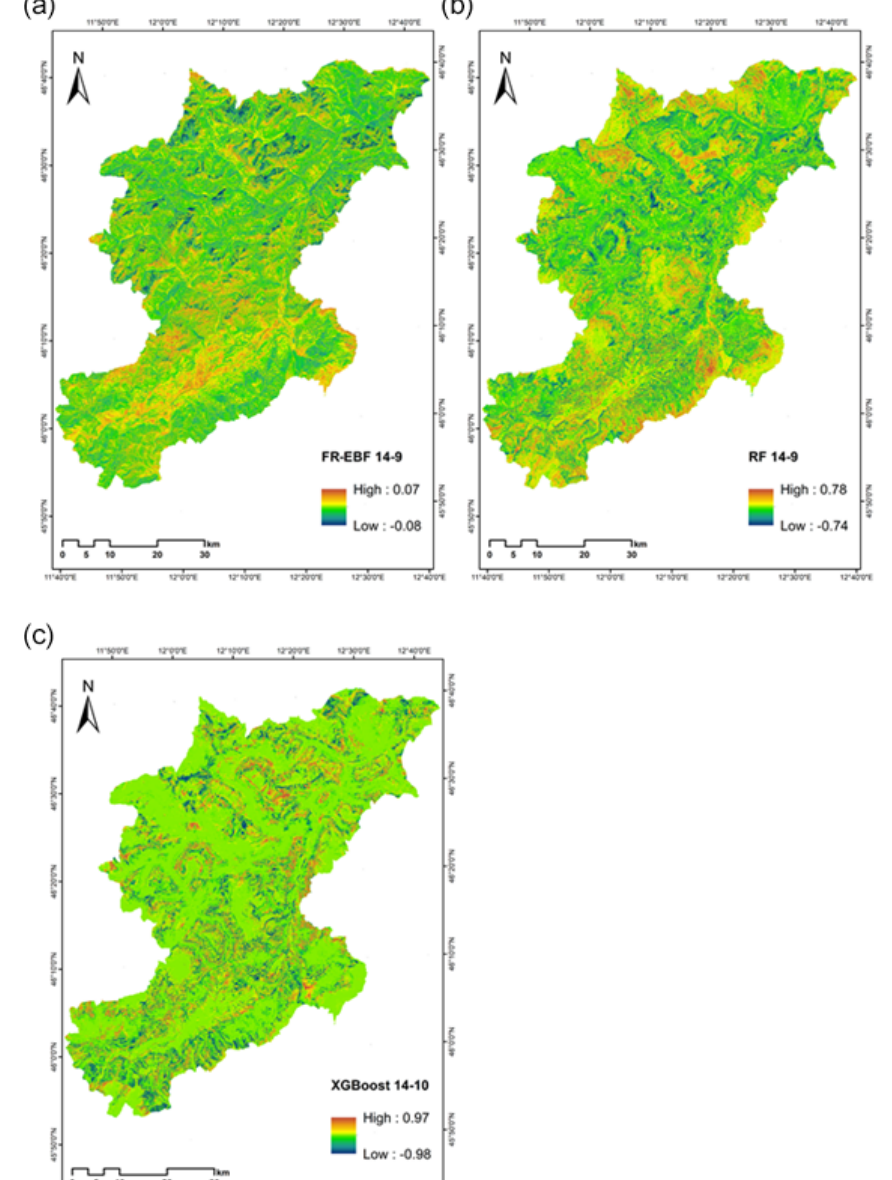
Figure 13. (a–c) Three comparison maps (uniform legend: red–blue band from − 1 to